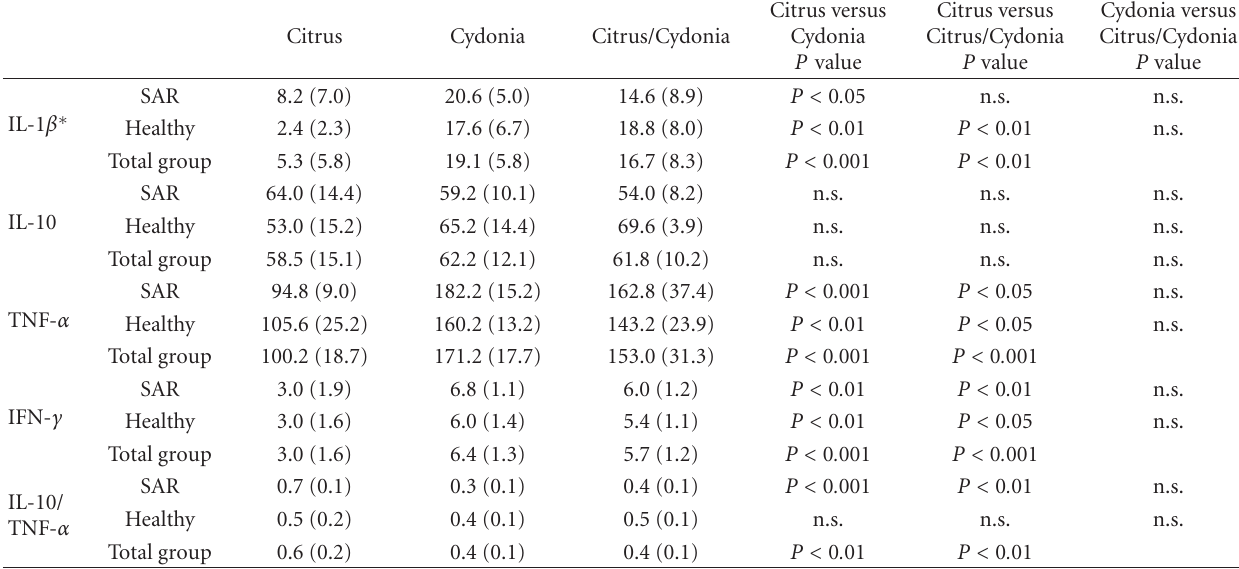
Table 2: Di ff erences in mean cytokine scores after one-day PBMC cultures in the SAR group, healthy group, and total group (grass pollen stimulation minus medium